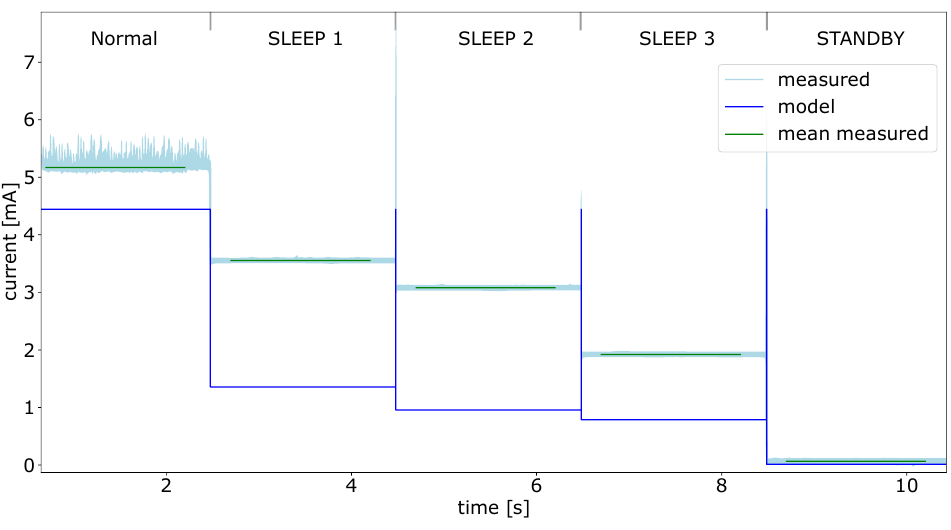
Figure 10. SPU modes power model data and measured current